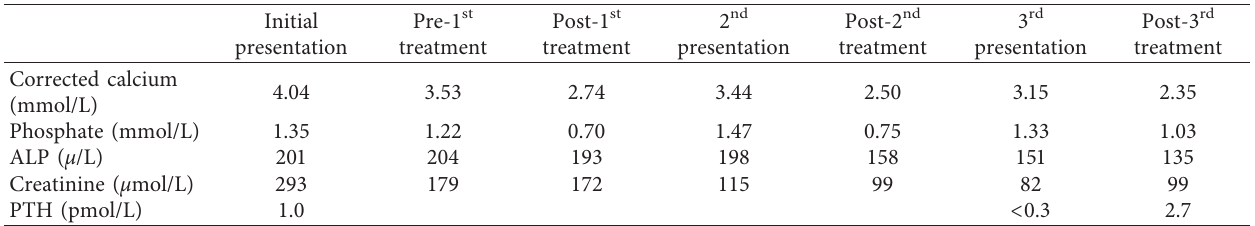
Figure 3: Anteroposterior (a) and lateral (b) plain radiographs of the right lower leg following six months of denosumab therapy, demonstrating significant interval change in the texture of the cyst, with evidence of new bone formation. Calcification of growth plates was noted which led to the decision to begin increasing the dose interval. Table 1: Summary of key lab values that were available at initial, and subsequent, presentations with hypercalcaemia, with levels pre- and post-bisphosphonate